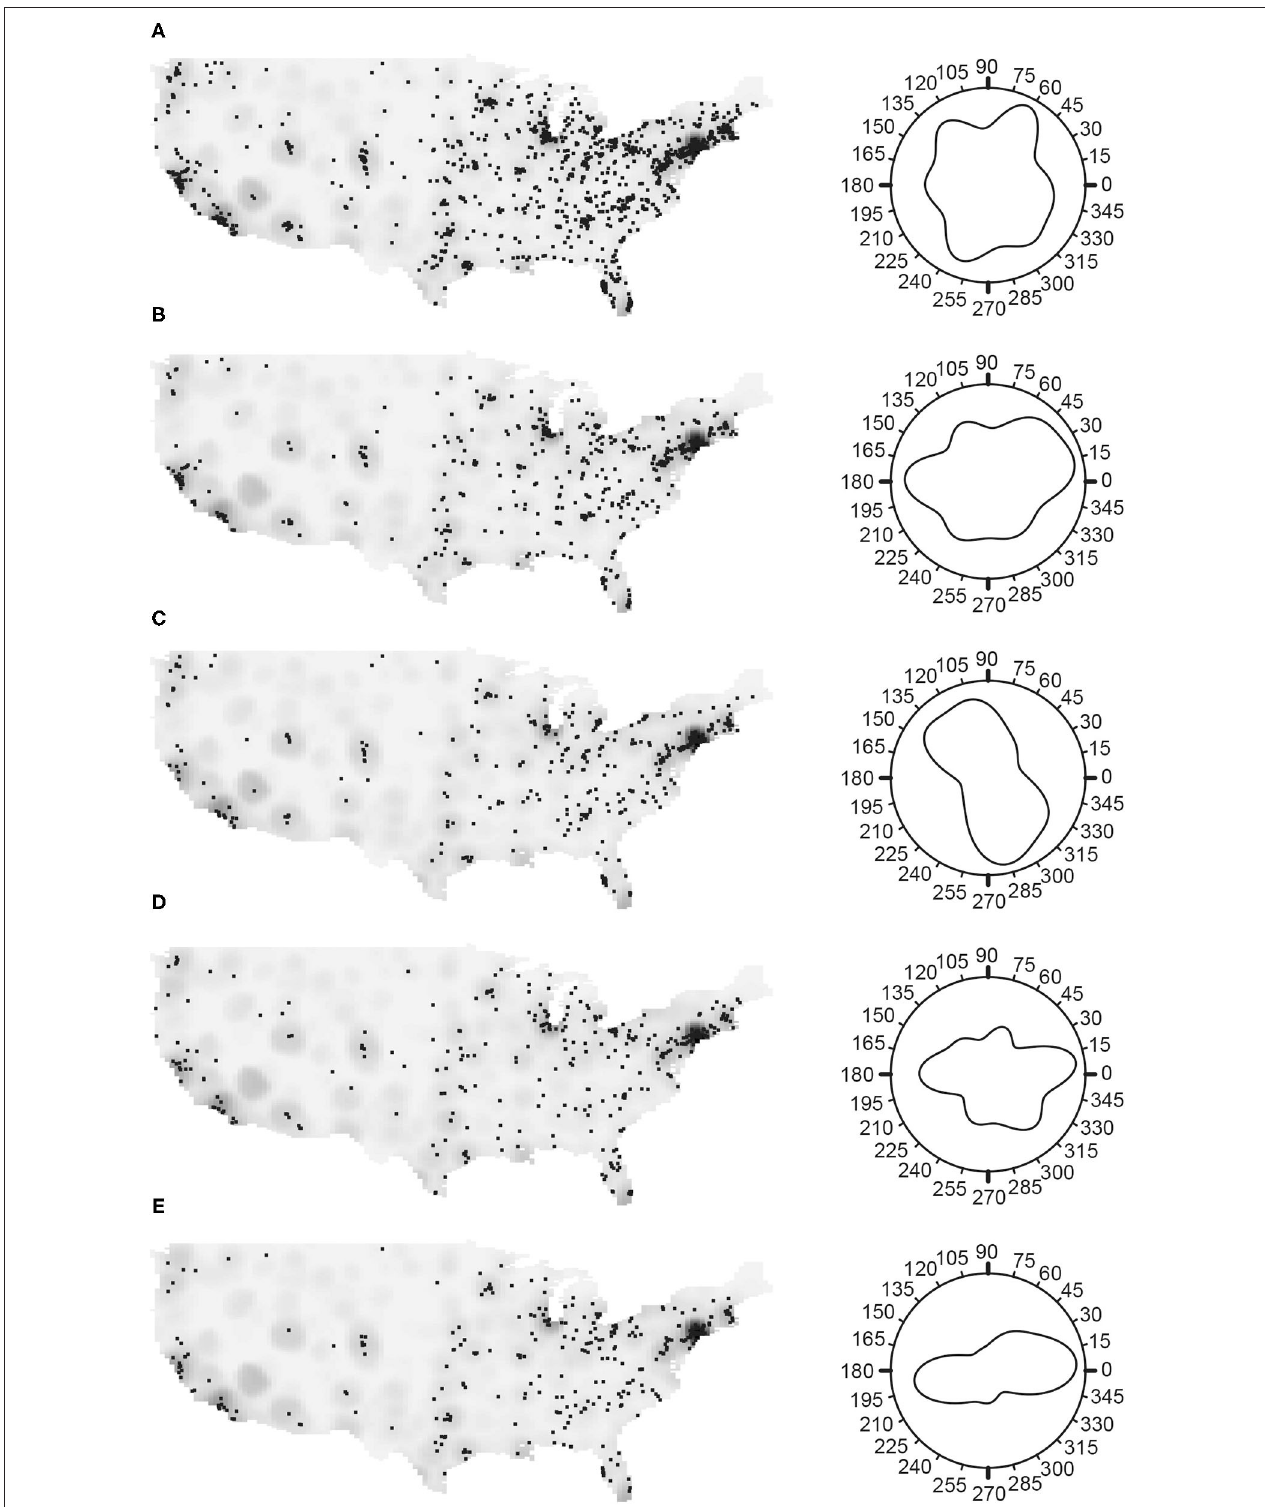
FIGURE 1 | The spatial distribution of myositis (IIM) cases in the MYOVSION National Myositis Patient Registry. The left panels show cases as black dots with population density in the gray background for the average U.S. population based on 2000 and 2010 censuses by census tract. In the right panels, Rose diagrams for the angular density of myositis cases using the counterclockwise from east convention. (A) All IIM; (B) Dermatomyositis; (C) Polymyositis; (D) Inclusion body myositis; and (E) IIM cases with lung disease.